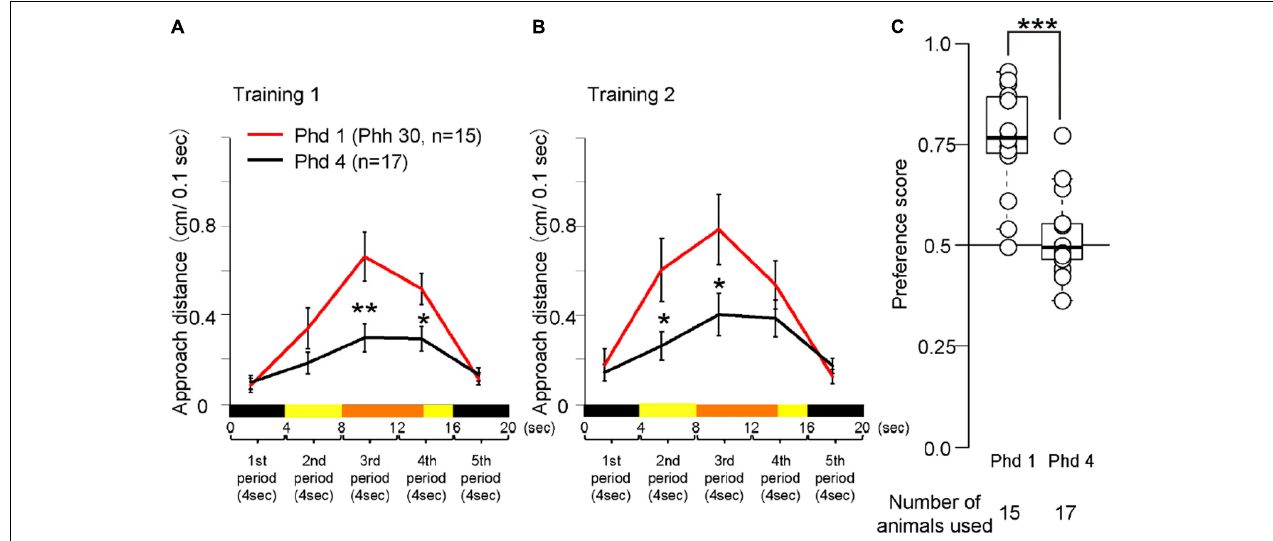
FIGURE 5 | Behavior of chicks at Phd 1 and 4 in the imprinting training and test. (A) Averaged approach distances in training 1 are shown. The red line indicates the approach distance of Phd 1 (Phh 30). The black line indicates the approach distance of chicks at Phd 4. In the third and fourth periods, the approach distances of chicks at Phd 4 were lower than those of chicks at Phd 1. (B) Averaged approach distances in training 2 are shown. In the second and third period, the approach distances of chicks at Phd 4 were lower than those of chicks at Phd 1. (C) Preference scores in the test are shown. Preference scores of chicks at Phd 4 were significantly lower than those of chicks at Phd 1. The asterisks (*) indicate significance (* p < 0.05; ** p < 0.01; *** p <